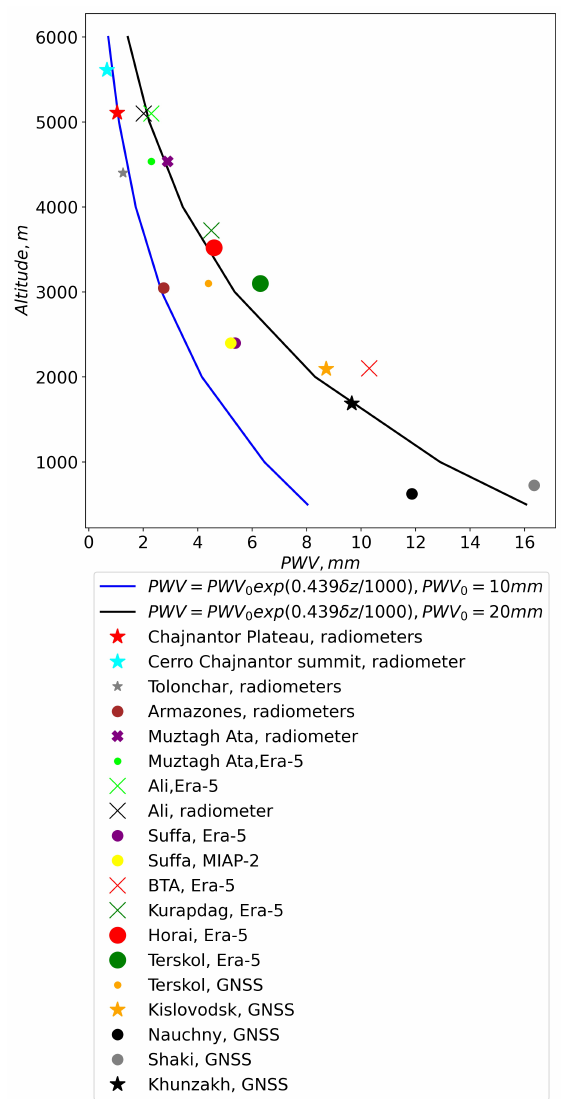
Figure 13. Dependencies of PWV medians on site elevation above sea